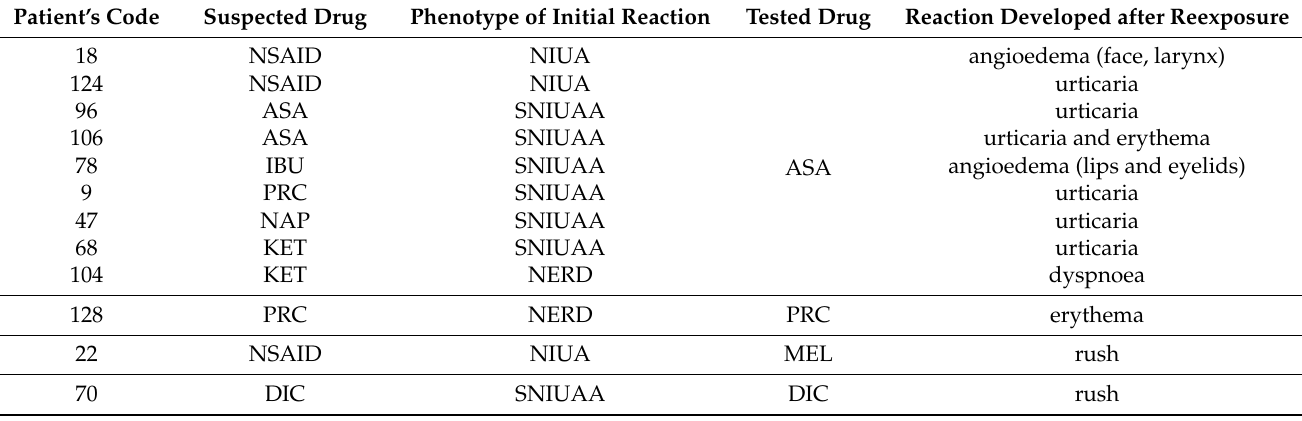
Table 1. Initial and subsequent drug-induced reactions in group A2.